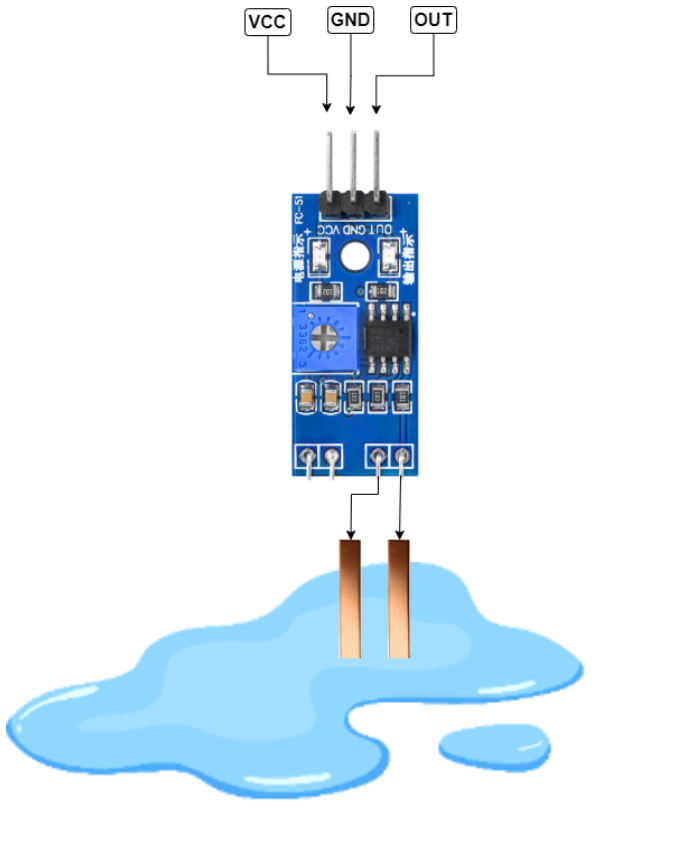
Figure 7. Water detection using copper